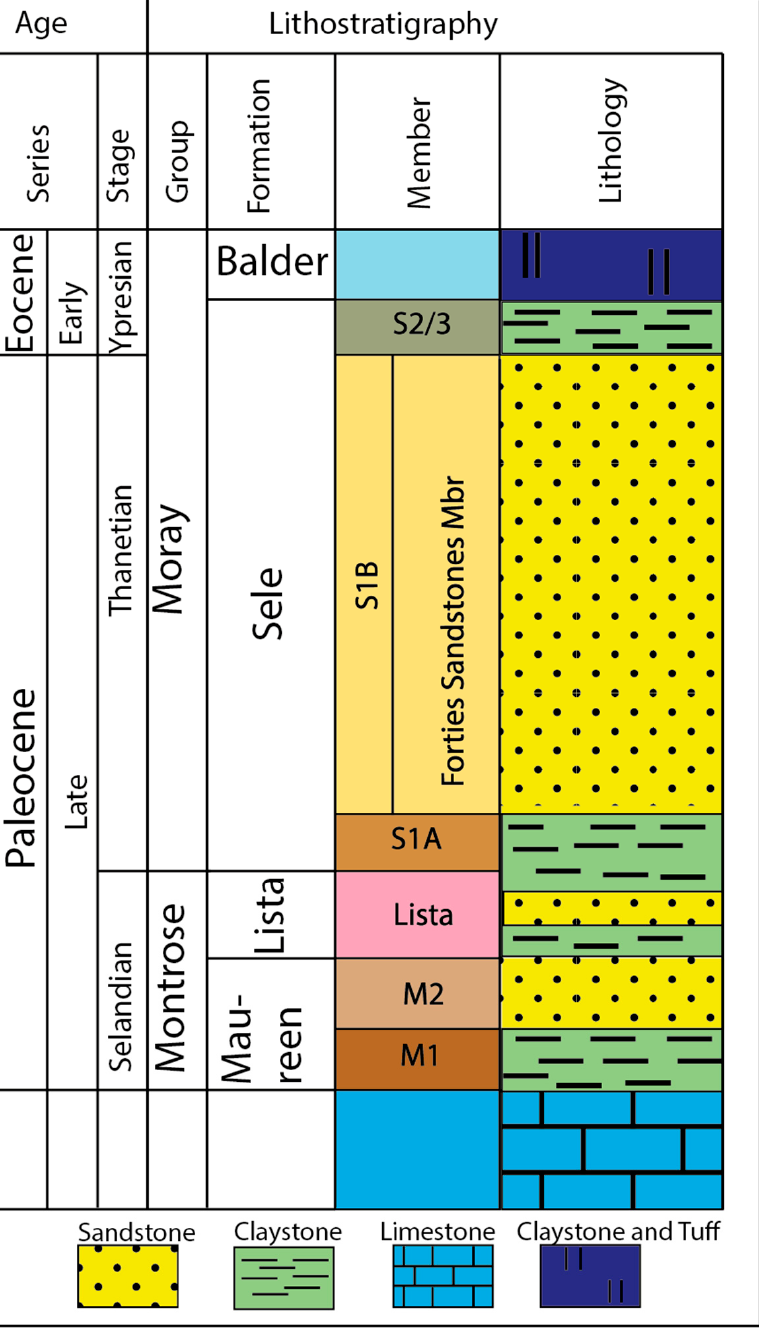
Figure 2. Stratigraphic column for the subsurface Paleocene and early Eocene formations, Central Graben, North Sea showing the studied Forties Sandstone Member of the Sele Formation.